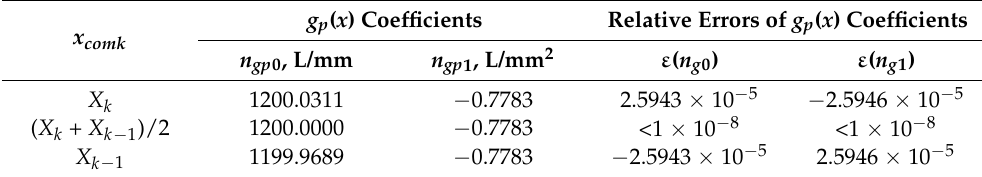
Table 2. g p ( x ) under the condition of f k = g ( X k ) and phase compensation with S k . g p ( x ) x comk